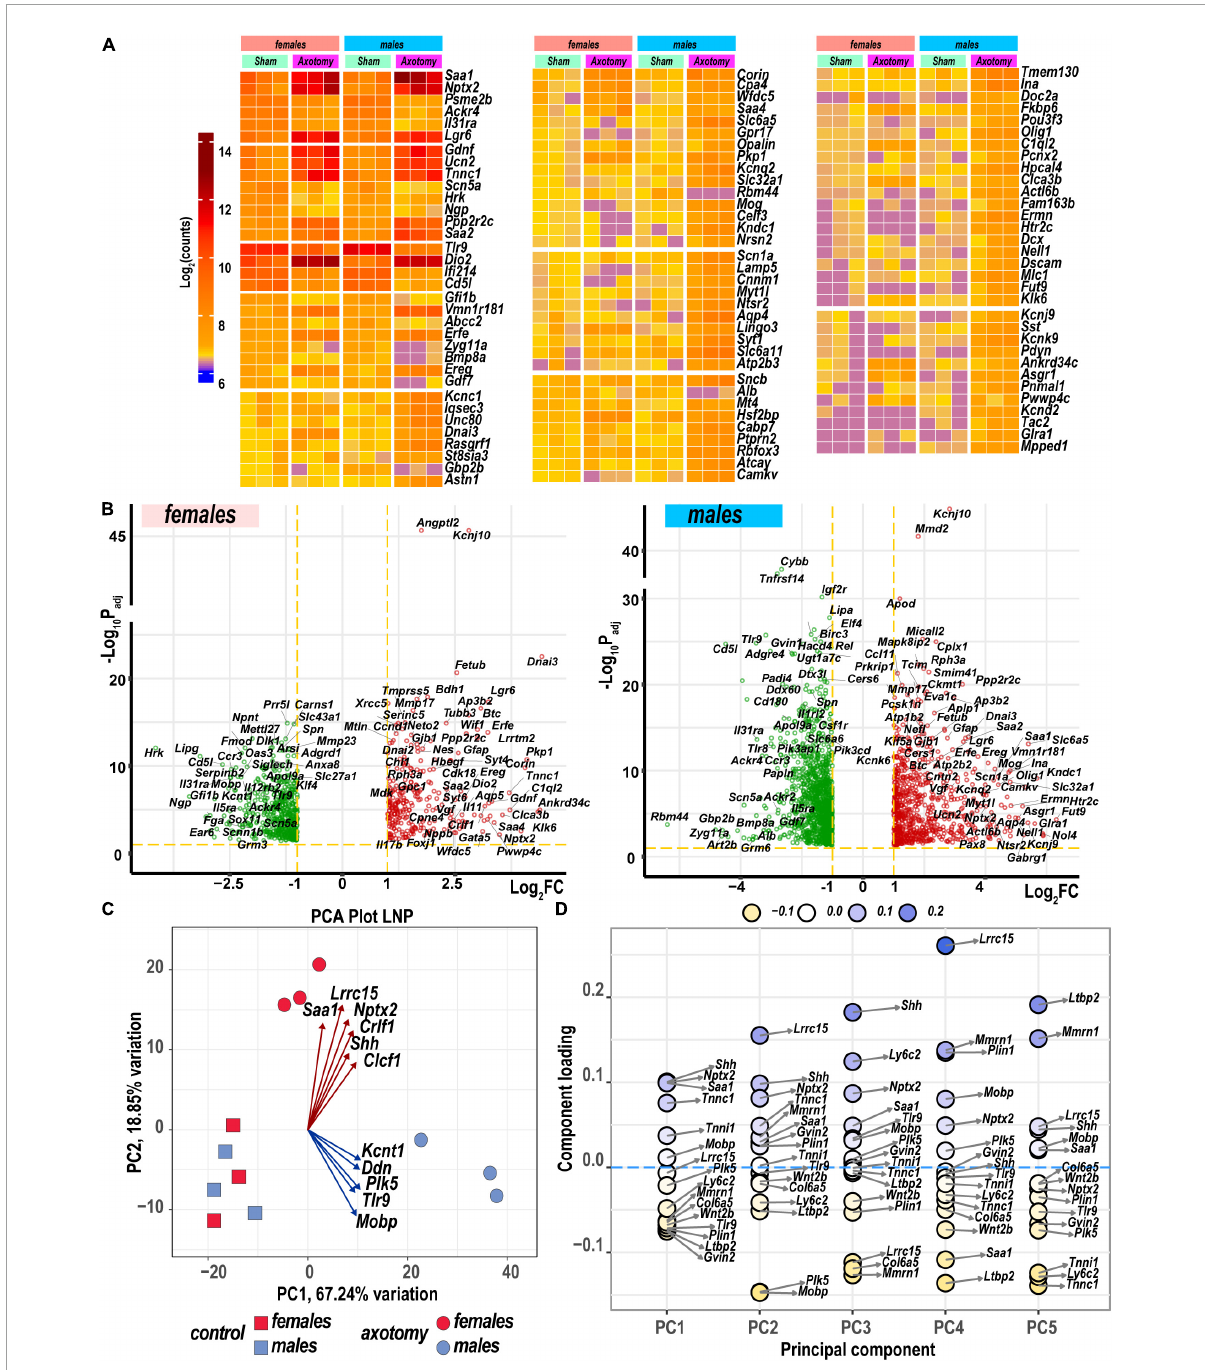
FIGURE2 Nerve axotomy induced distinct sexually dimorphic regulation of differentially expressed genes (DEGs) in female and male mice. (A) Hierarchical clustering plot of 300 most significant upregulated DEGs (log 2 FC > 1, P adj < 0.1, n = 6 mice/group, 2 mice/sample (pooled), 3 sample/group). Heatmap colors correspond to mean log 2 (counts)—Blue, yellow, and red – low, medium, and high expression, respectively. DEGs were sorted by log 2 FC. (B) Significant DEGs in female (left panel) and male (right panel) mice. Volcano scatter plots show –log 10 P adj and log 2 FC. Red and green colors indicate up- and down-regulated DEGs, respectively. Thresholds (log 2 FC > 1 or log 2 FC < –1) and –log 10 P adj < 0.1 are indicated by yellow dashed lines. Selected DEG symbols are shown. (C) Principal component analysis of female (red) and male (blue) groups of sham (rectangles) and axotomy (circles) samples ( n = 3 samples/group). Red and blue arrows indicate genes with the most influence on variance in females and males, respectively. (D) A principal component analysis (PCA) loading plot indicates genes influencing variance in the top five PCA projections (PC1 to PC5) within the top/bottom 5% of the loadings range. The dot color scale corresponds to component loading coefficients defined as the coordinates of the variables divided by the square root of the eigenvalue associated with the